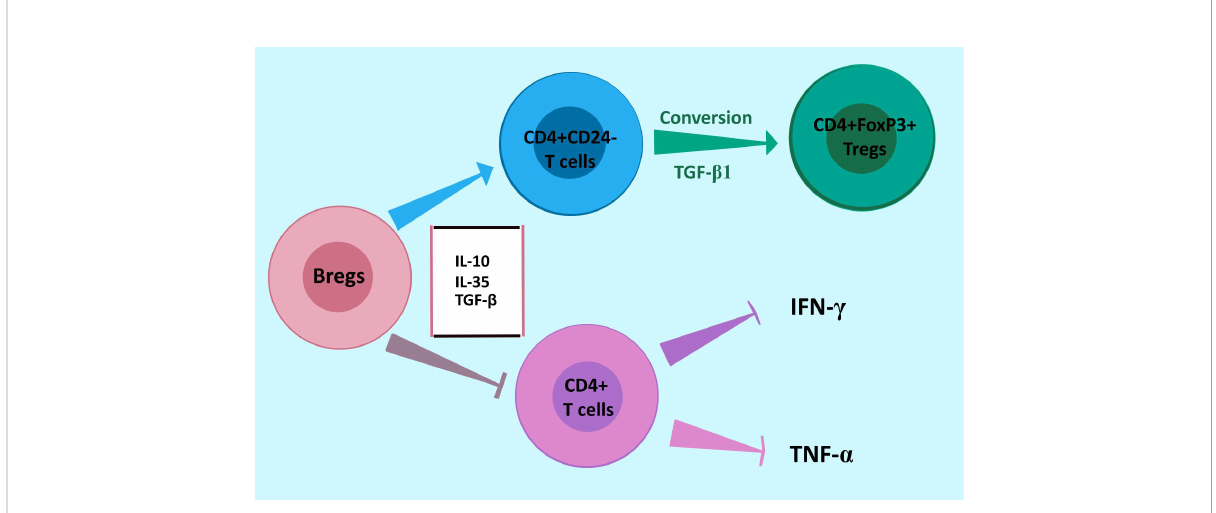
FIGURE 4 Bregs response in gastric cancer to promote immune escape. Bregs promote the conversion of CD4 + CD25 - effector T cells to immunosuppressing CD4 + FoxP3 + Tregs by producing TGF- b 1. Moreover, Bregs impair the anti-tumor response by suppressing the secretion of IFN- g and TNF- a by CD4 + T cells. Abbreviations: Bregs, regulatory B cells